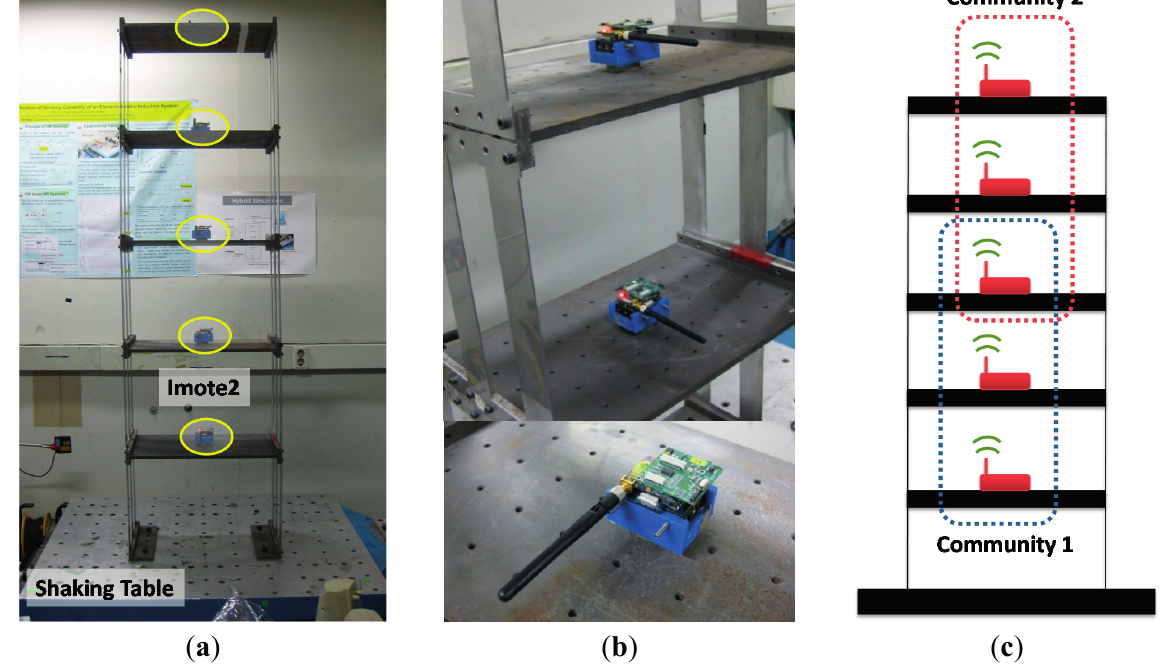
Figure 5. Experimental setup. ( a ) Shear building; ( b ) Installed Imote2; ( c ) Network